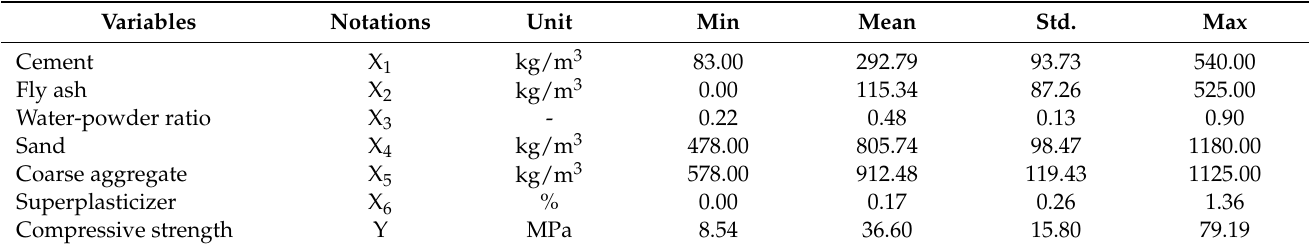
Table 4. The variables used in the Dataset 3.